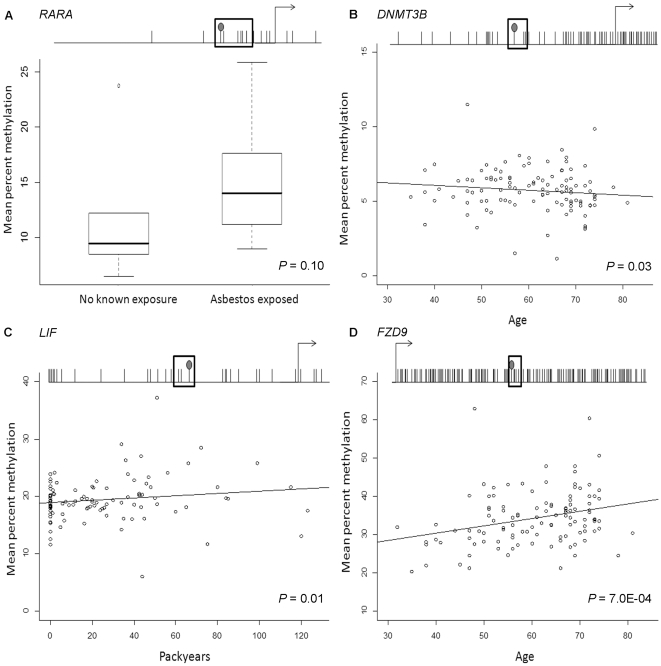
Bisulfite pyrosequencing confirmation of age and environmental exposure–related methylation alterations observed in array results.Each plot displays the gene transcription start site and surrounding CpGs are indicated by tick marks where the array CpG tick mark has a filled circle on top, and the sequenced CpGs are surrounded by a box. (A) Distribution of mean bisulfite pyrosequencing percent methylation for RARA_P176 and five downstream CpGs (79 bases total) stratified by known exposure to asbestos in DNA from pleural samples (n = 16) confirms the observation from array results of increased methylation at this locus among individuals with a known asbestos exposure (P = 0.10). (B) Mean bisulfite pyrosequencing percent methylation of DNMT3B_P352 and two downstream CpGs (30 bases total) in adult bloods run on the array and an independent set of controls plotted versus age (P = 0.03, rho = ––0.18, n = 112). (C) Mean bisulfite pyrosequencing percent methylation of LIF_P383 and two downstream CpGs (41 bases total) in adult bloods run on the array and an independent set of controls plotted versus smoking packyears (P = 0.01, rho = 0.24, n = 112). (D) Mean bisulfite pyrosequencing percent methylation of FZD9_E458 and five downstream CpGs (25 bases total) in adult bloods run on the array and an independent set of controls plotted versus age (P = 7.0E-04, rho = 0.29, n = 112).